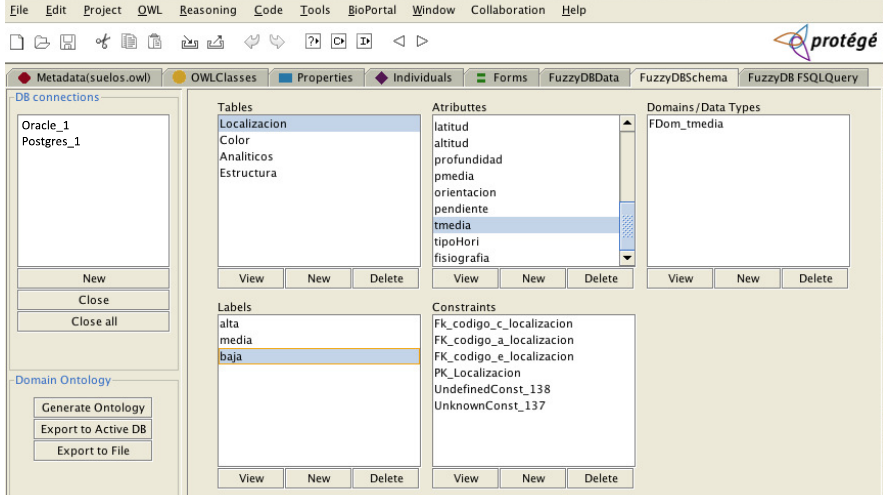
Fig. 8. Prot´eg´e plug-in to define fuzzy